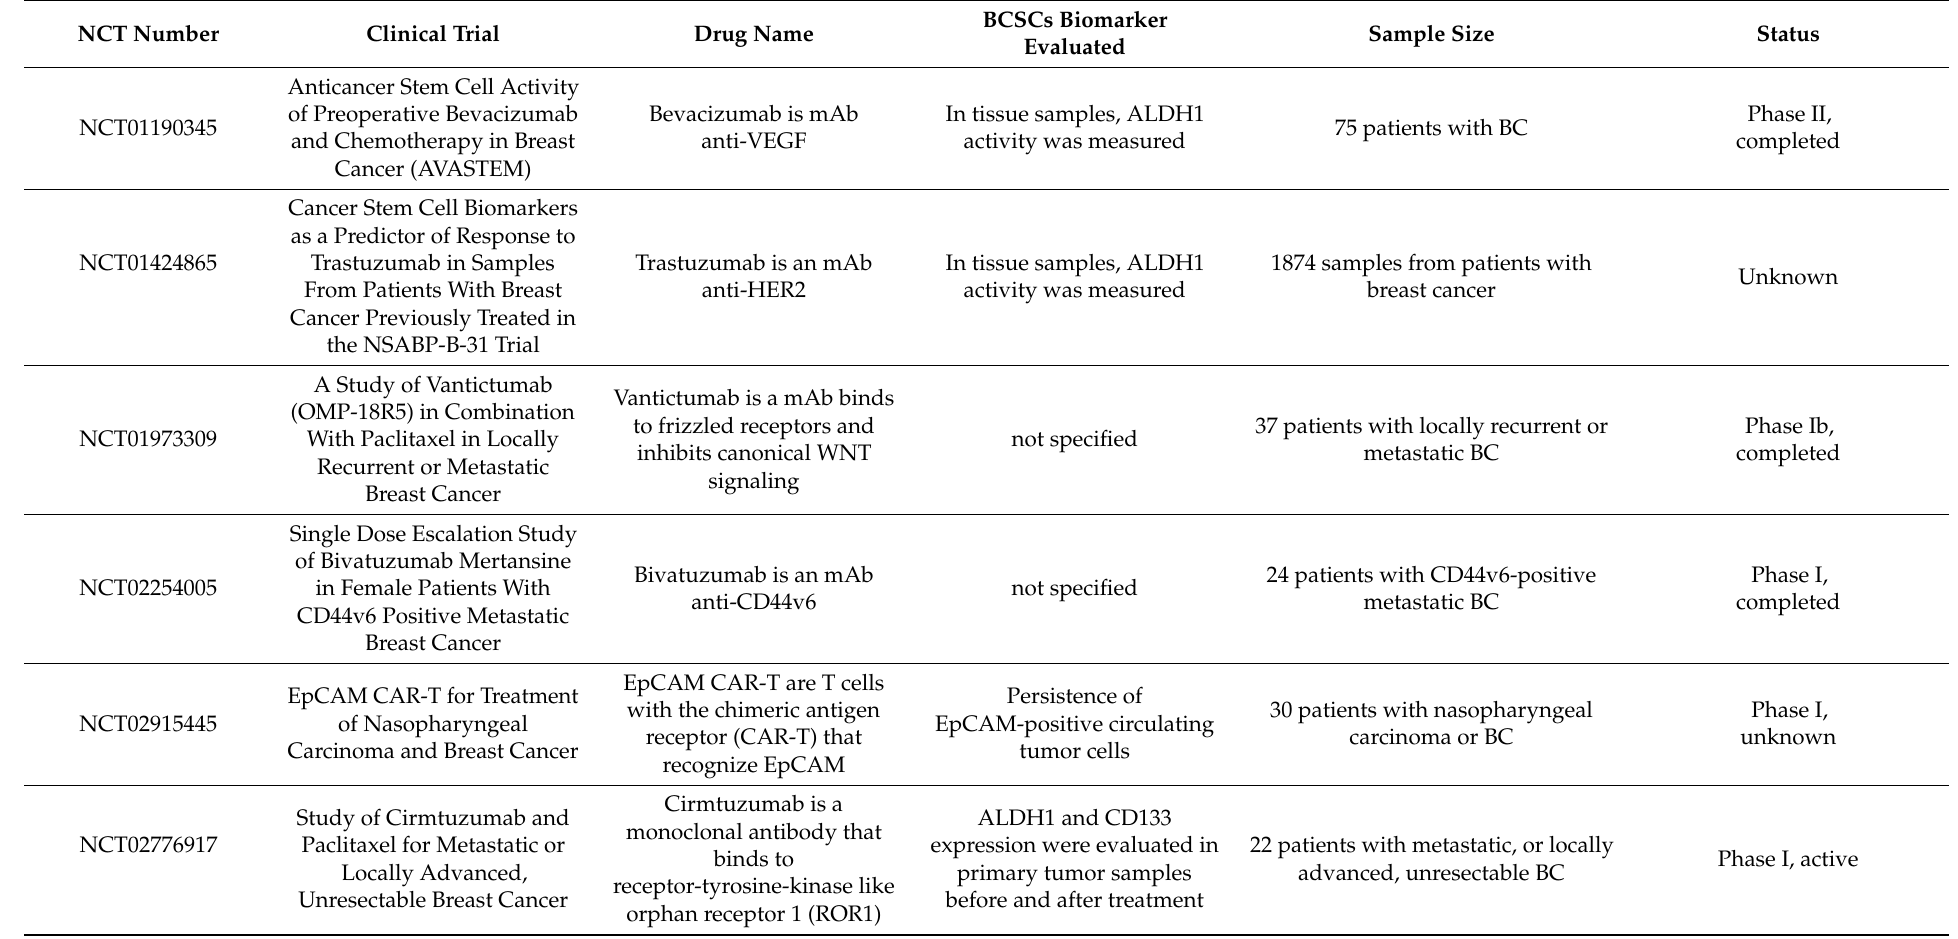
Table 2. Clinical trials of therapeutic agents targeting breast cancer stem-like